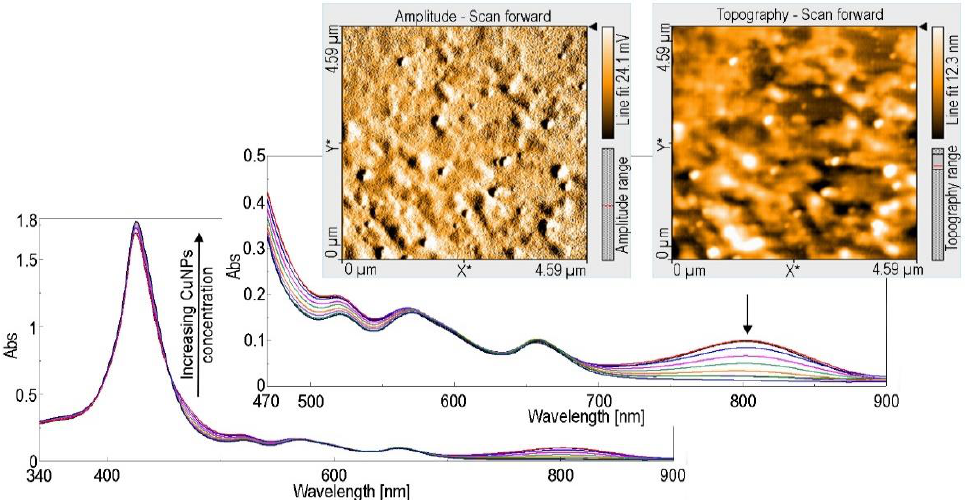
Figure 3. UV-vis spectrometry of CuNPs interference with TAmPP and AFM images of TAmPP-CuNPs complex.